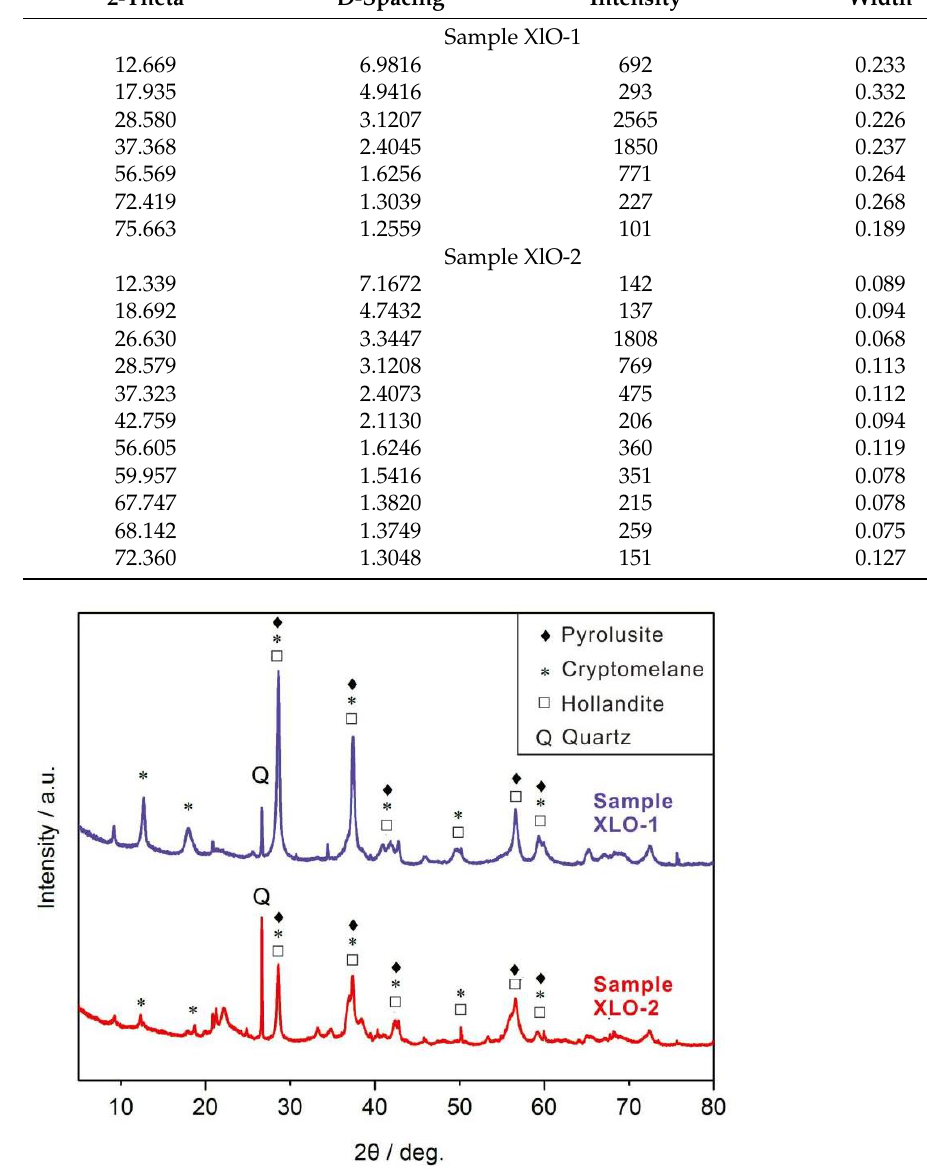
Figure 8. X-ray powder diffraction patterns of the Mn-oxide ore for samples XLO-1 and XLO-2.